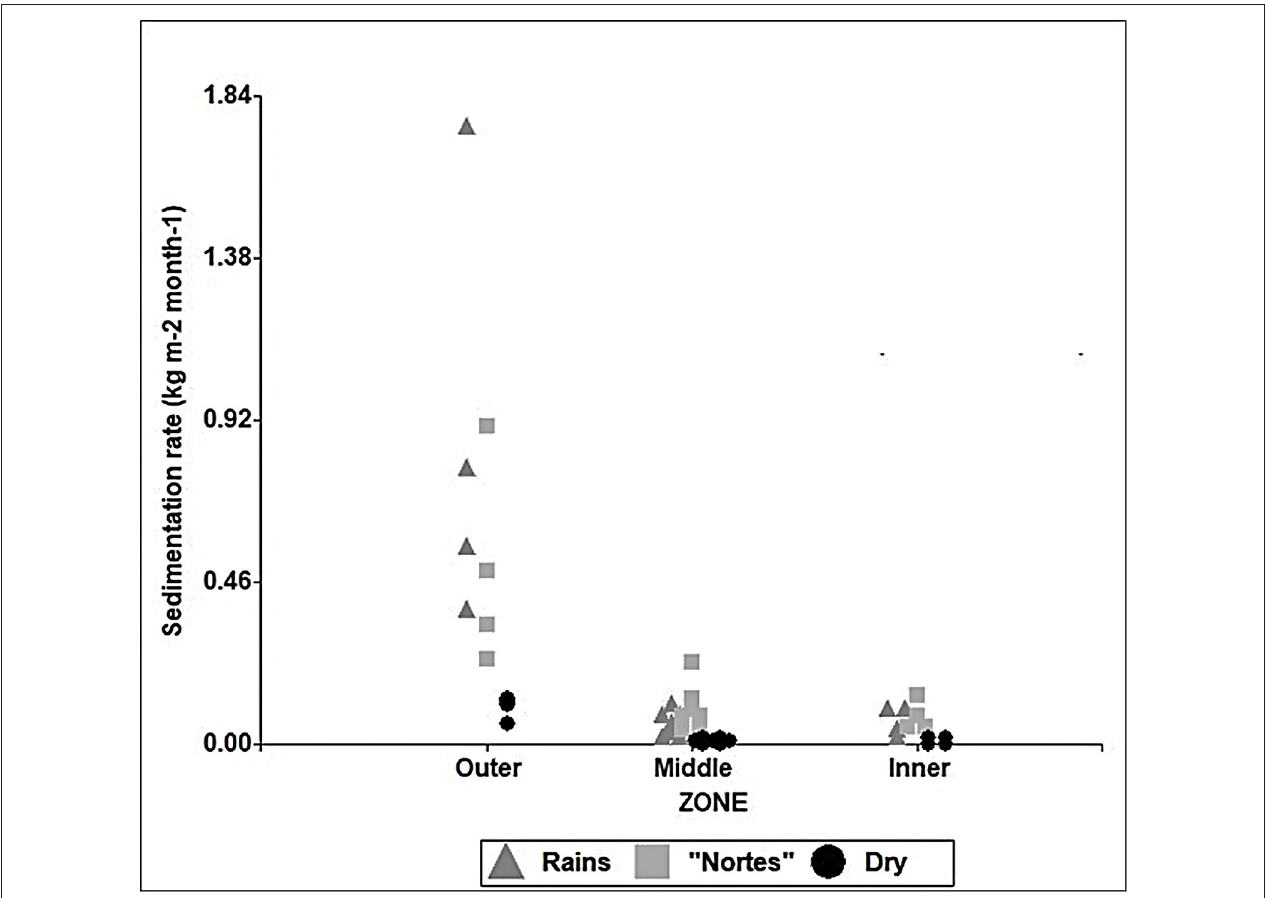
FIGURE 2 | Sedimentation rate (kg m − 2 month − 1 ) during three seasons (rains, nortes, dry) according to lagoon zones (Outer, Middle, Inner) in Celestun